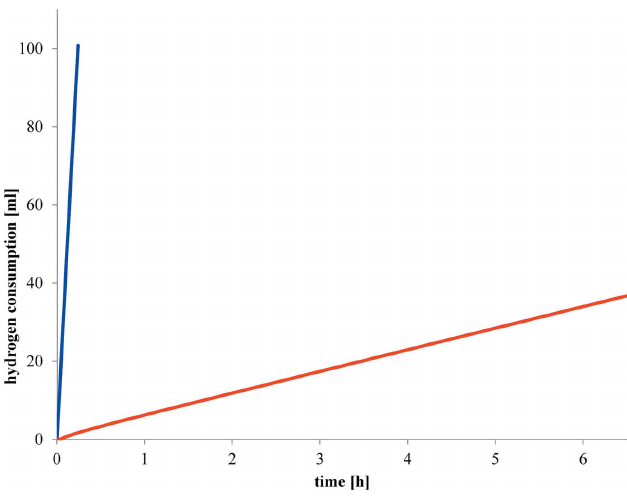
Figure 2 First part (first double bond) of the hydrogen consumption for the hydrogenation Figure 1